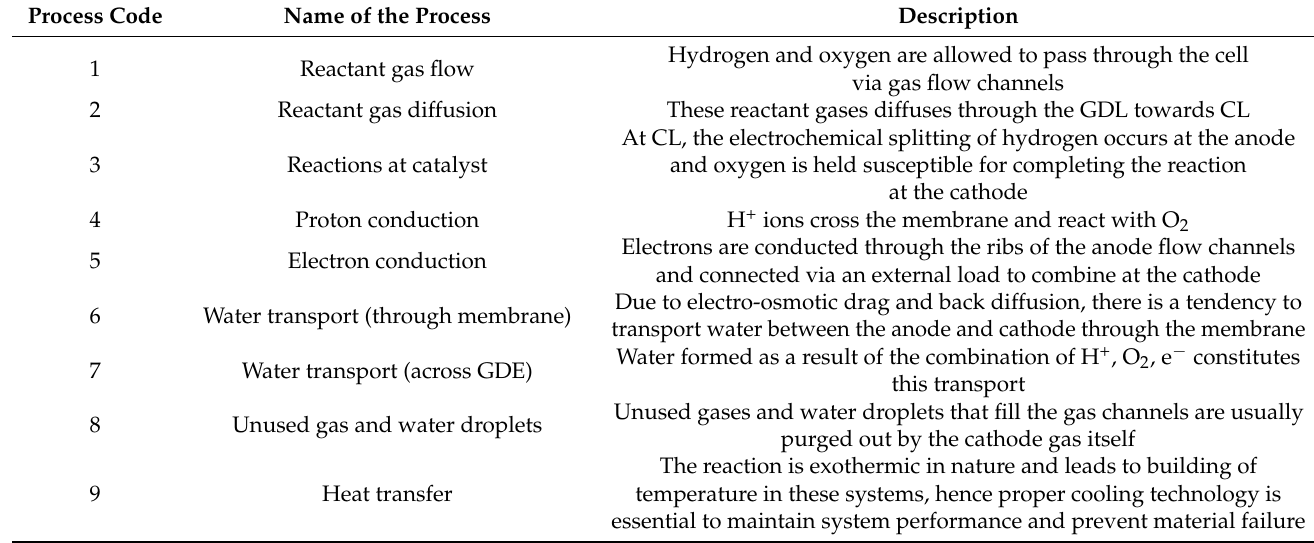
Figure 3. Schematic diagram of fuel cell components and associated processes. (This conceptual image is re-drawn from the cited reference). Table 5. Fuel cell processes and description (with reference to Figure